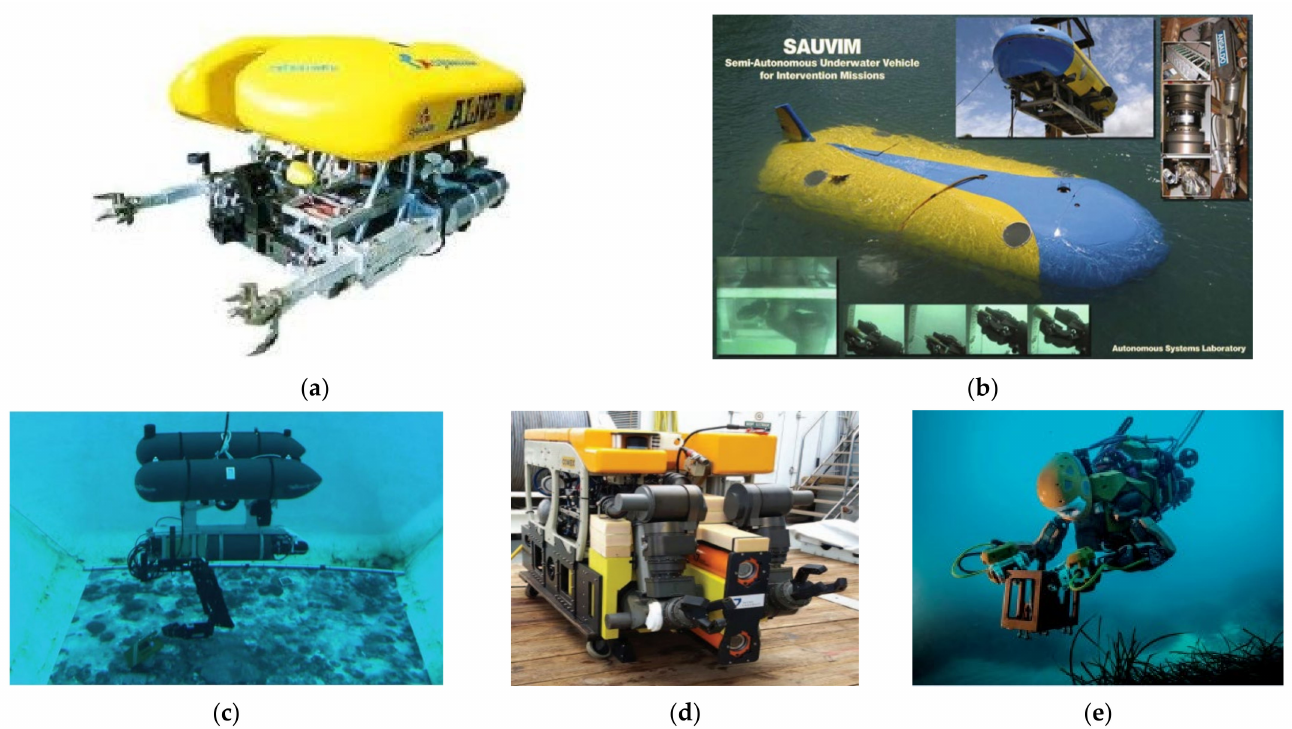
Figure 1. Different kinds of UVMS: ( a ) ALIVE [11]; ( b ) SAUVIM [22]; ( c ) GIRONA 500 [23]; ( d ) DexROV [19]; ( e ) Ocean One